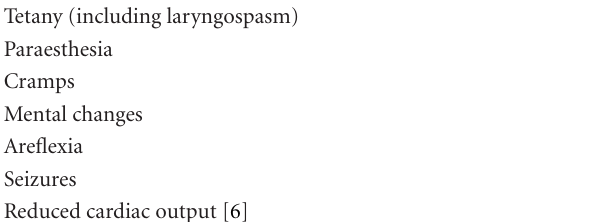
Table 4: Clinical features of hypocalcemia.